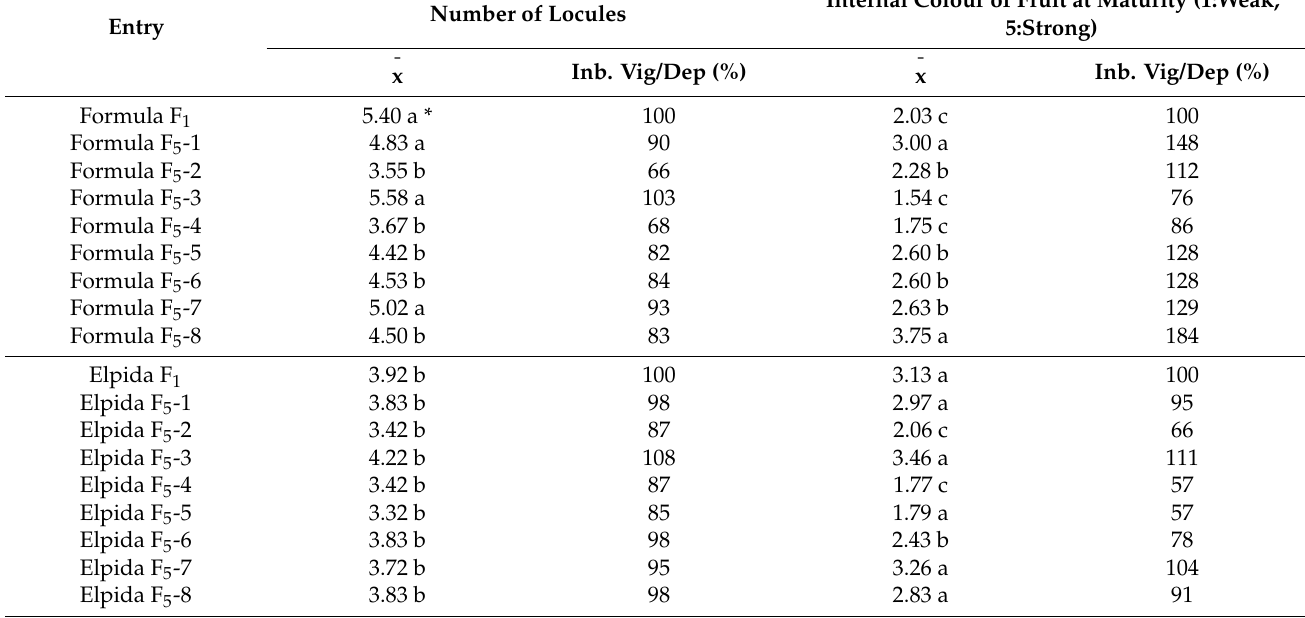
Table 5. Average number of locules in fruit, internal fruit color intensity at maturity, and inbred vigor/depression (% of corresponding hybrid), for tomato hybrids and recombinant inbred lines. Internal Colour of Fruit at Maturity Number of Locules Entry